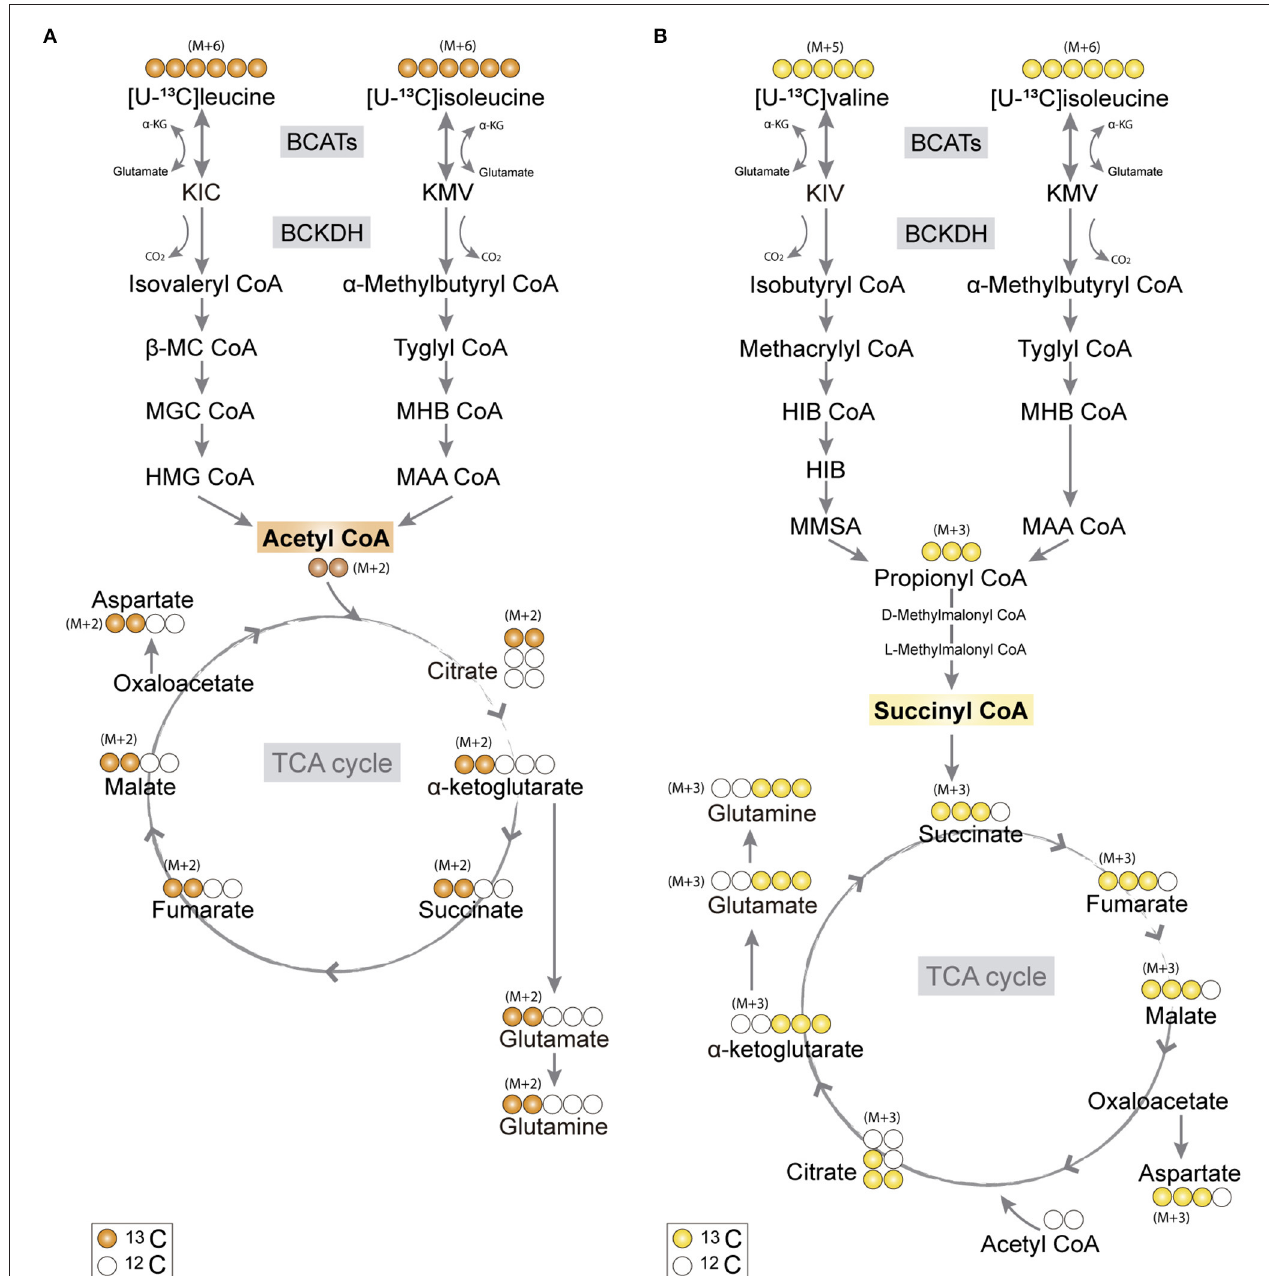
FIGURE 1 | Primary 13 C-labeling patterns from [U- 13 C]branched-chain amino acid (BCAA) metabolism. (A) Metabolism of [U- 13 C]leucine and [U- 13 C]isoleucine (M + 6) will result in acetyl coenzyme A (CoA), a process initiated by branched-chain aminotransferase (BCAT) catalyzing BCAA transamination and hereby producing branched-chain α -keto acids (BCKAs), α -ketoisocaproate (KIC), and α -keto- β -methylvalerate (KMV), respectively. Subsequently, irreversible oxidative decarboxylation of the BCKAs occurs by the branched-chain α -keto acid dehydrogenase (BCKDH) enzyme complex and through multiple enzymatic reactions entering the TCA cycle as double-labeled acetyl CoA (M + 2). Filled circles (orange) represent labeled 13 C and empty circles unlabeled 12 C. (B) Valine and isoleucine can also enter into the TCA cycle via succinyl CoA. [U- 13 C]valine (M + 5) and [U- 13 C]isoleucine (M + 6) will be transaminated, resulting in BCKAs, α -ketoisovaleric (KIV), and KMV, respectively, and then decarboxylated, entering TCA cycle metabolism, after numerous reactions, as succinate (M + 3). Filled circles (yellow) represent labeled 13 C and empty circles unlabeled 12 C. BCATs, branched-chain aminotransferase; BCKDH, branched-chain α -keto acid dehydrogenase; α -KG, α -ketoglutarate; KIC, α -ketoisocaproate; KMV, α -keto- β -methylvalerate; KIV, α -ketoisovaleric; β -MC CoA, β -methylcrotonyl CoA; MGC CoA, β -methylglutaconyl CoA; HIB CoA, β -hydroxyisobutyryl CoA; MHB CoA, α -methyl- β -hydroxyisobutyryl CoA; HMG CoA, β -hydroxy- β -methylglutaryl CoA; MAA CoA, α -methylacetoacetyl CoA; HIB, β -hydroxyisobutyrate; MMSA, methylmalonate semialdehyde; MAA CoA, α -methylacetoacetyl